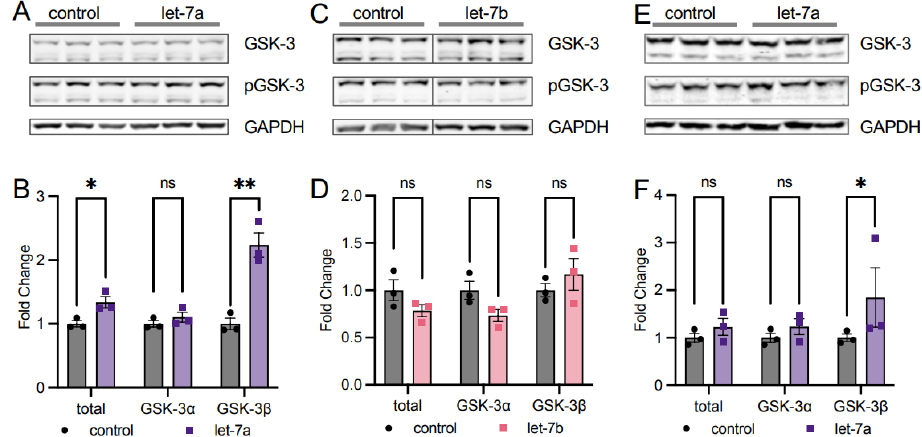
Figure 5. let-7a activation of AKT1 increases downstream phosphorylation of the substrate GSK-3. ( A ) Western blots and ( B ) quantification of GSK-3 and pGSK-3 in HEK 293T cells co-transfected with 60 fmol let-7a (purple squares) or a control lacking RNA (black circles) and mCherry-AKT1 for 24 h and stimulated with epidermal growth factor (EGF) for 15 min. ( C ) Western blots and ( D ) quantification of GSK-3 and pGSK-3 in HEK 293T cells co-transfected 60 fmol let-7b (pink squares) or a control lacking RNA (black circles) and mCherry-AKT1 for 24 h and stimulated with epidermal growth factor (EGF) for 15 min. ( E ) Western blots and ( F ) quantification of GSK-3 and pGSK-3 in COS-7 cells co-transfected with 60 fmol let-7a (purple squares) or a control lacking RNA (black circles) and mCherry-AKT1 for 24 h and stimulated with epidermal growth factor (EGF) for 15 min. Note that all graphs show relative phosphorylation of the AKT substrate GSK-3 in respective exper- imental conditions. The data include n = 3 biological replicates. Error bars show ± 1 SEM. Asterisks indicate significance (ns, not significant; * p < 0.05, ** p < 0.01).